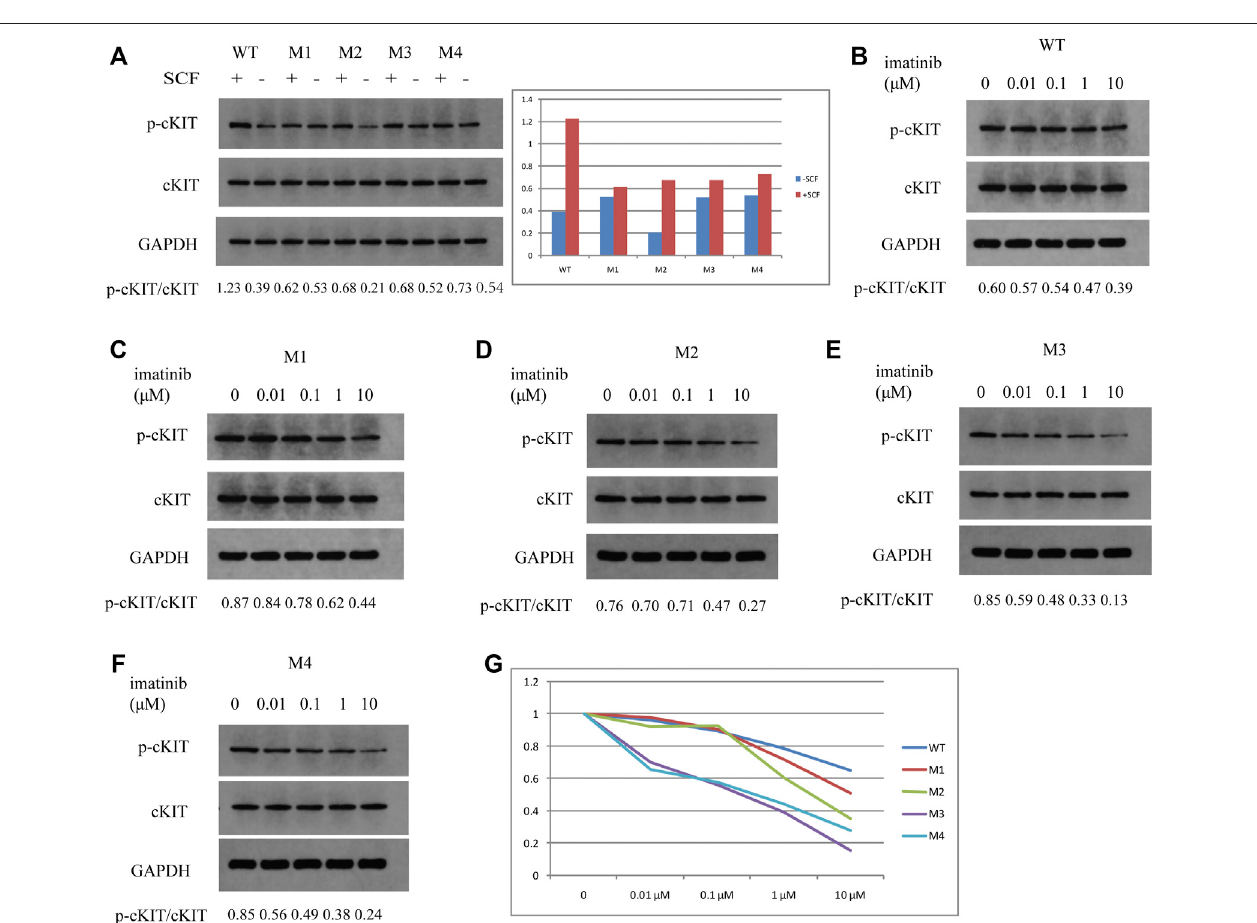
FIGURE 4 | Western blotting detection in SK-MEL-28 cells treated by SCF or imatinib at different concentrations for each plasmid. The ratios of p-cKIT to cKIT accurateto0.01areshownatthebottomofeachpanel. (A) c-KITandphospho-c-KITlevelsafterSCFtreatmentforwildtype,M1,M2,M3,andM4.Thevaluesofp-cKIT tocKITareshown inthebar chartfortheseplasmidstreated(+SCF)ornottreatedbySCF(-SCF). (B) c-KITandphospho-c-KITlevelsinwild-type-transfectedcellsafter imatinib treatment at concentrations of 0, 0.01, 0.1, 1, and 10 μ M. (C) c-KIT and phospho-c-KIT levels in M1-transfected cells after imatinib treatment at concentrationsof0,0.01,0.1,1,and10 μ M. (D) c-KITandphospho-c-KITlevelsinM2-transfectedcellsafterimatinibtreatmentatconcentrationsof0,0.01,0.1,1,and 10 μ M. (E) c-KITandphospho-c-KITlevelsinM3-transfectedcellsafterimatinibtreatmentataconcentrationof0,0.01,0.1,1,and10 μ M. (F) c-KITandphospho-c-KIT levels in M4-transfected cells after imatinib treatment at concentrations of 0, 0.01, 0.1, 1, and 10 μ M. (G) Values of p-cKIT to cKIT are displayed in the line chart for each plasmid at imatinib concentrations of 0, 0.01, 0.1, 1, and 10 μ M relative to the individual value at 0 μ